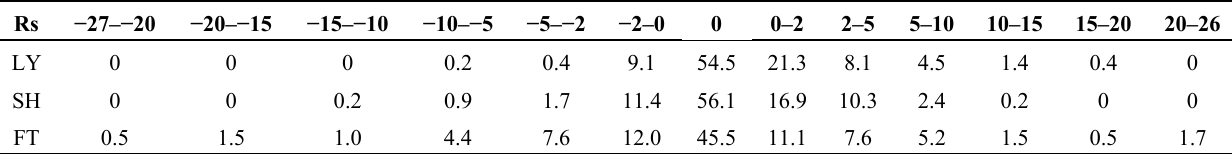
Table 12. Statistic distribution of Rs variation in Scenario S1-S0 (area percentage, %). Rs SH